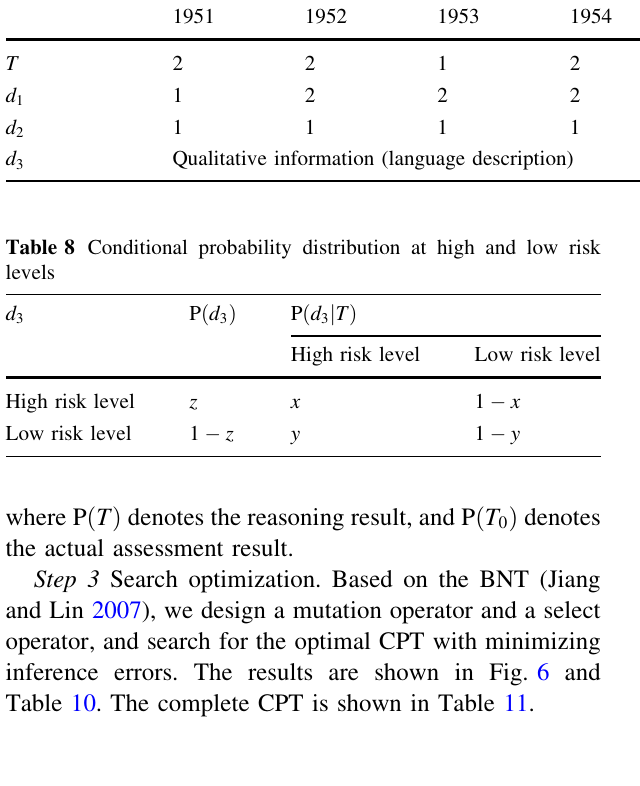
Table 7 Discrete samples for Bayesian network training and testing